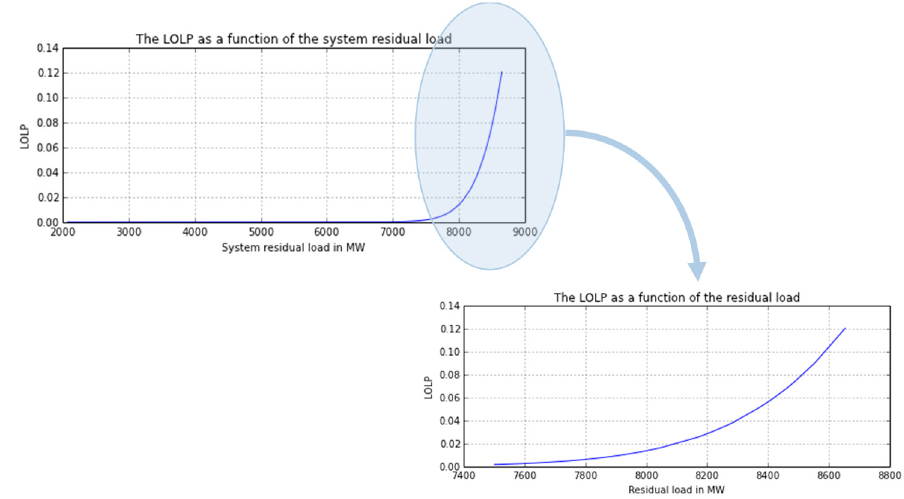
Figure A4. LOLP as a function of the Greek system load.